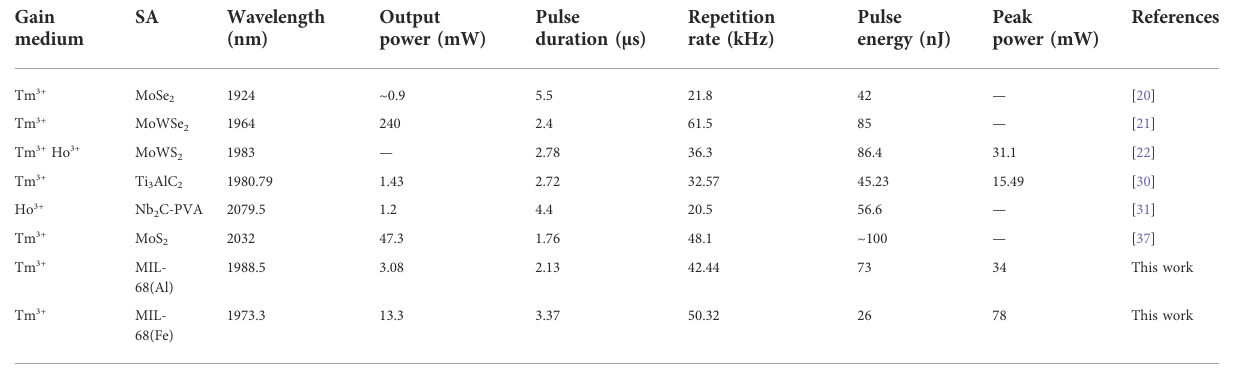
TABLE 1 Comparison of this work with other selected 2D-materials for the two-micron region. Gain medium